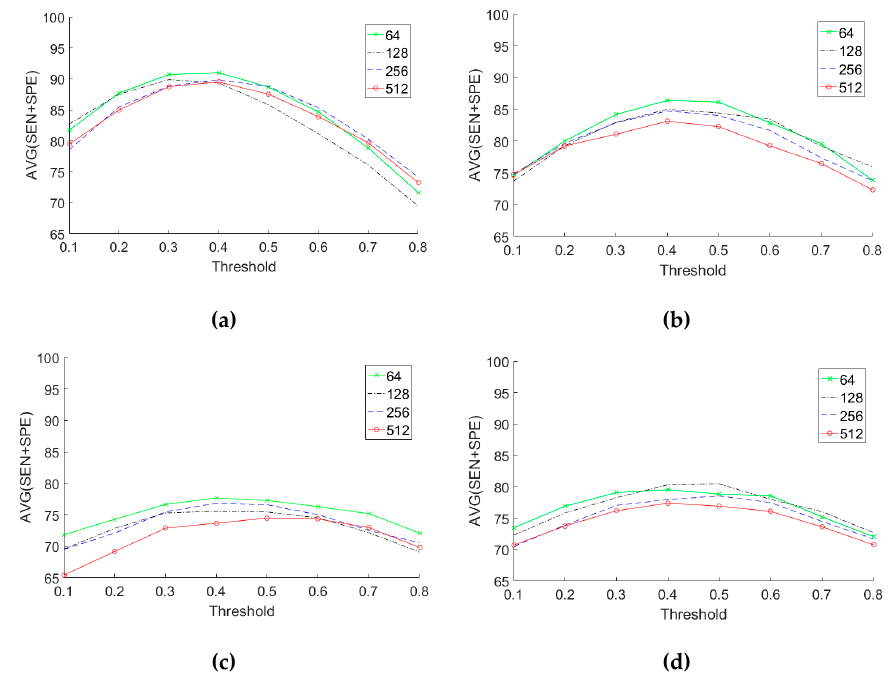
Figure 11. Effect of the hidden layer size and the presence thresholds 𝑇 (cid:3043) on the AVG score for the